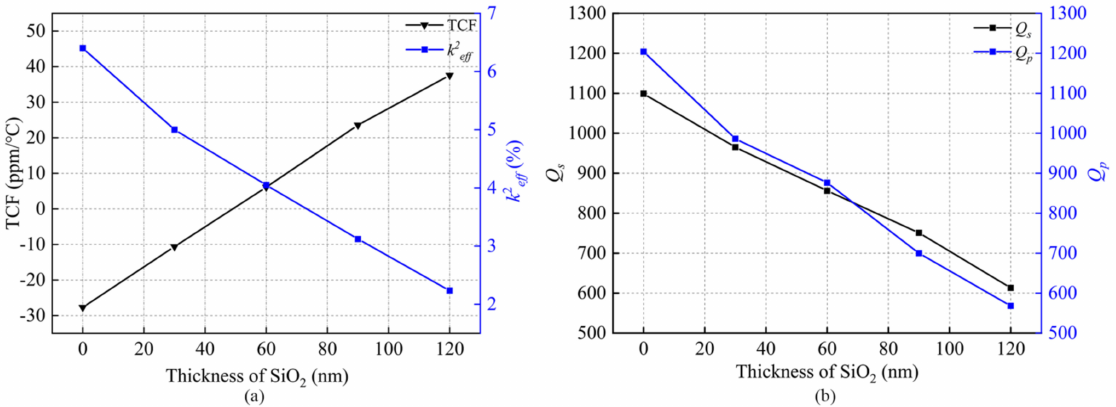
Figure 12. ( a ) Relationship between TCF , k 2 eff , and thickness of the SiO 2 film. ( b ) Q with different